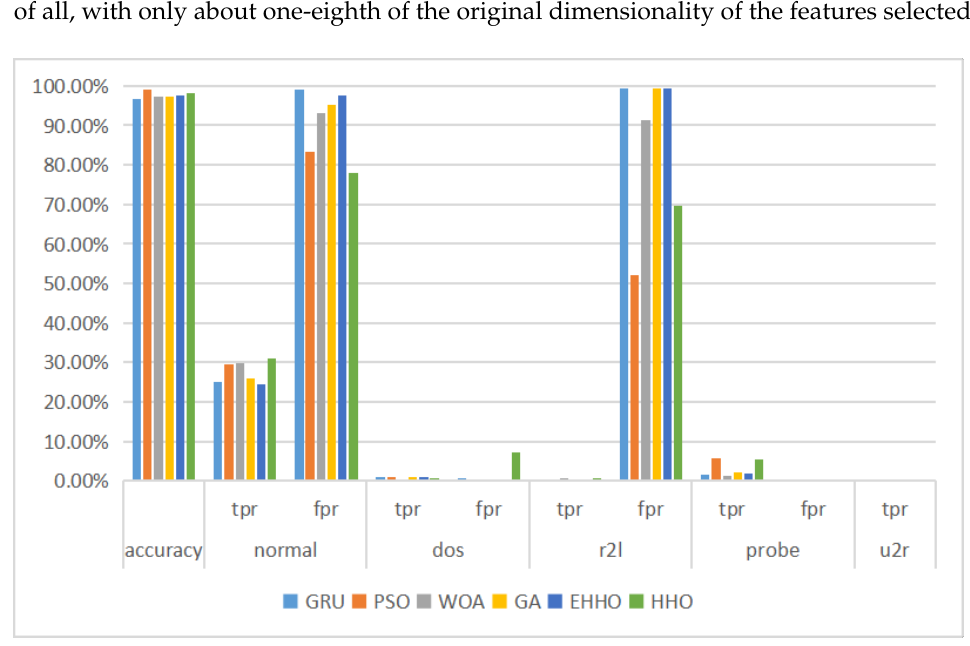
Figure 10. Multi-classification histogram of